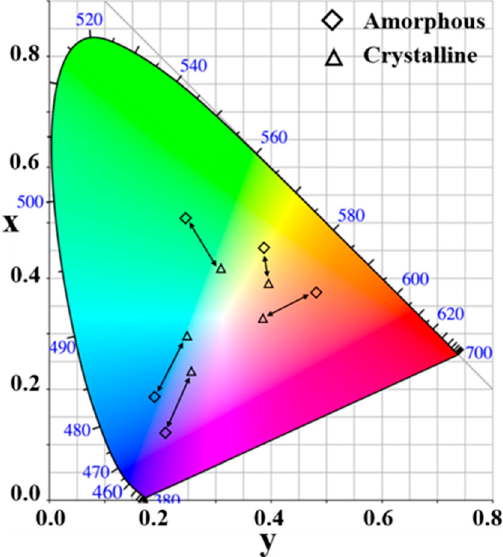
Figure 5. Color coordinates evaluated from the Amorphous (square shape) and Crystalline (triangle shape) reflection spectrum, described on the CIE 1931 chromaticity diagram.